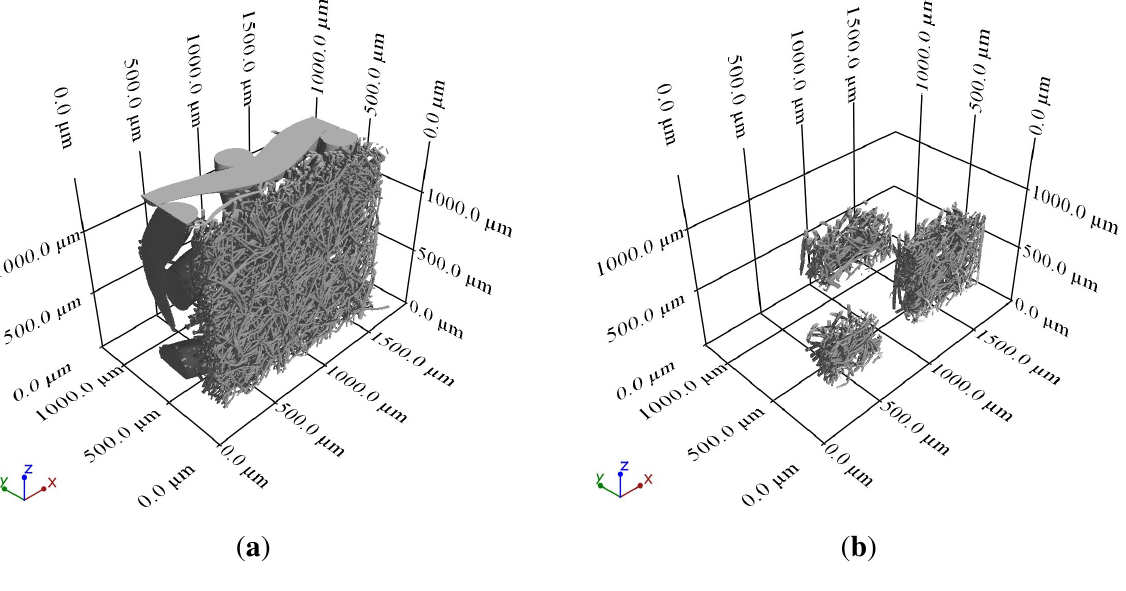
and d ), flow resistivity measured by the 1 2 2